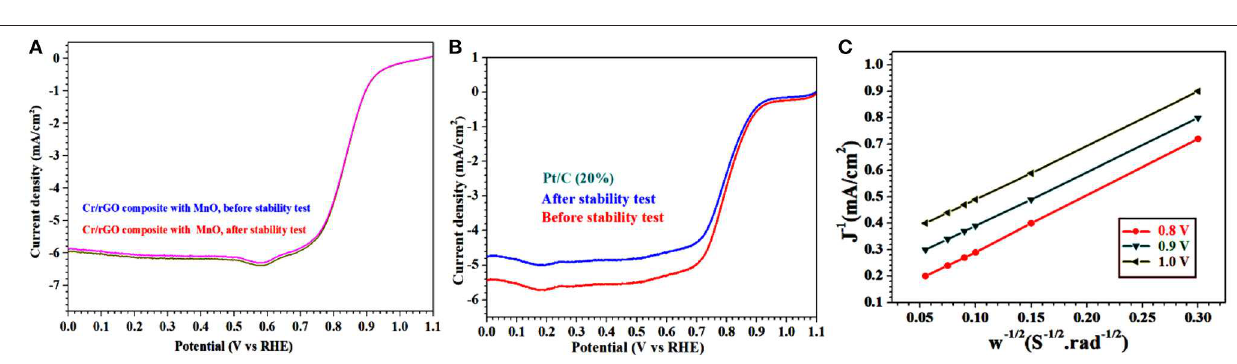
FIGURE 10 | (A,B) LSV curves of Cr/rGO composite with MnO and 20% Pt/C before/after 20,000 potential cycles in O 2 -saturated 0.1M KOH and at 1,600 rpm. (C) K-L plots of Cr/rGO composite with MnO at different potentials. LSV, linear sweep voltammetry; rGO, reduced graphene oxide; K-L,